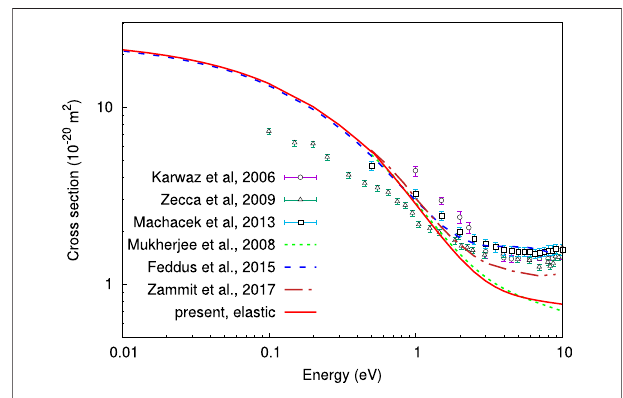
FIGURE5| (Coloronline)Elastic(presentresult)and totalcrosssections for positron scattering from H 2 . The present result correspond to a model potential with κ =1, ρ =1.85 and γ